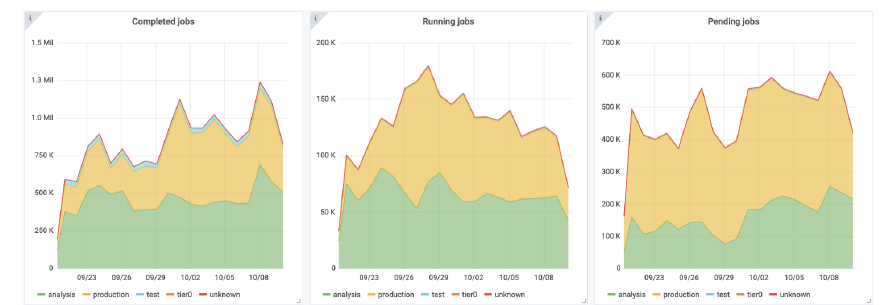
Figure 3. Screenshot of the CMS job monitoring